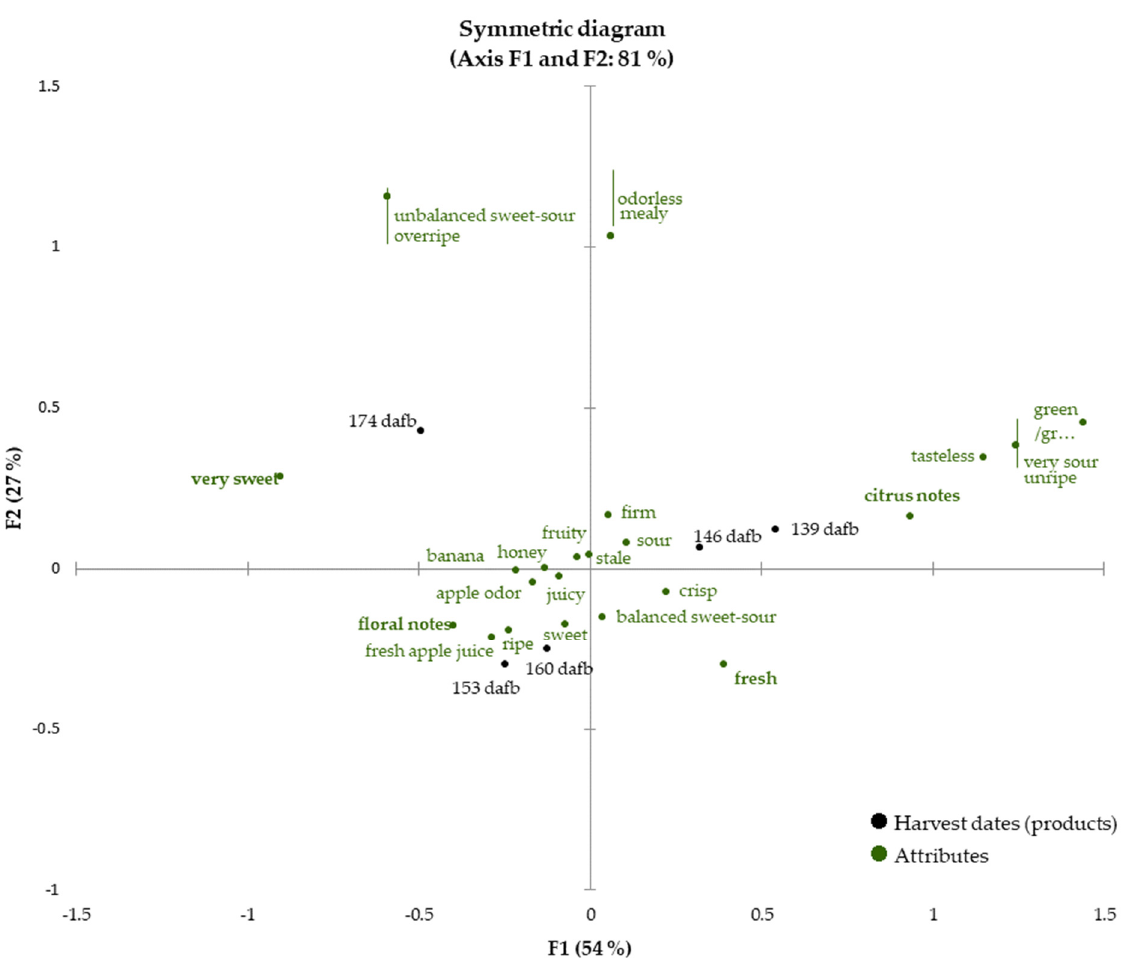
Figure 3. Check-all-that-apply (CATA) analysis of the apples harvested between 139 to 174 dafb. The harvest dates (products) are printed in black, all attributes are colored in green. Discriminating attributes ( p < 0.05) are printed in